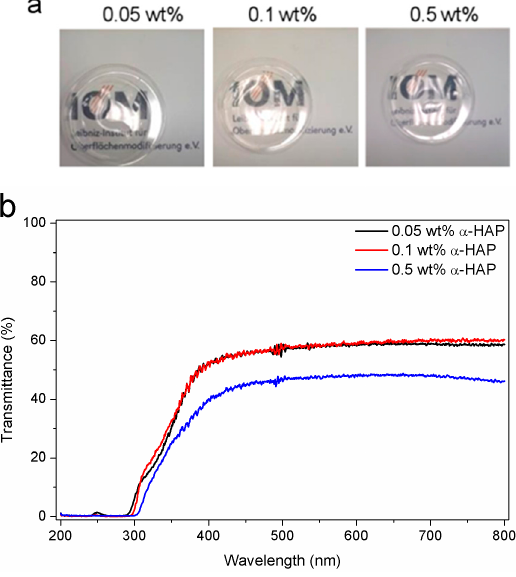
Figure 4. Photographs of the final materials ( a ) and transparency measurements of the samples ( b ) made with three different photoinitiator concentrations: 0.05 wt %, 0.1 wt %, and 0.5 wt %.